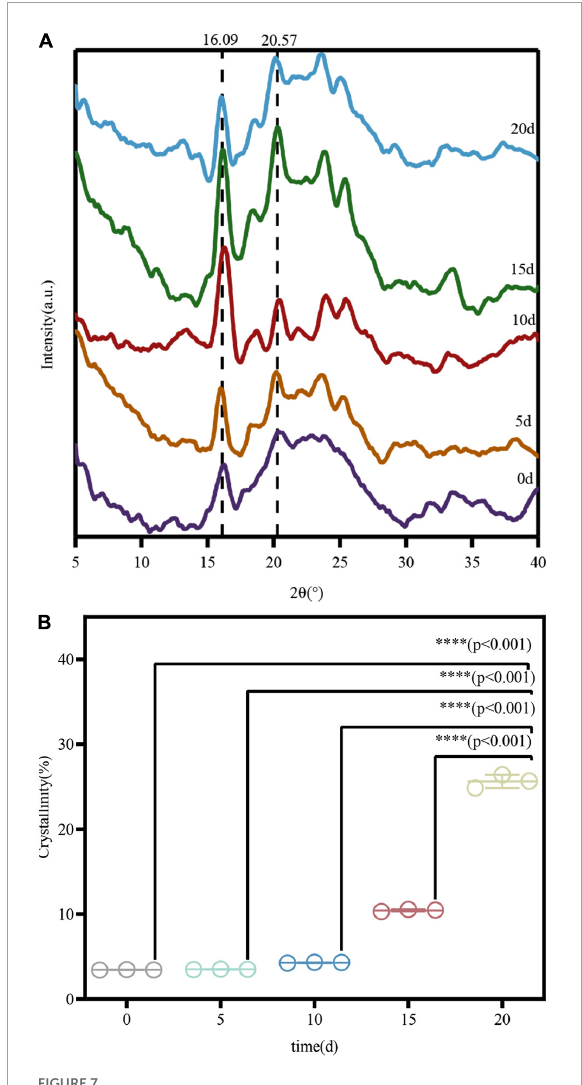
FIGURE6 Infrared spectral analysis of COC before and after biological treatment.